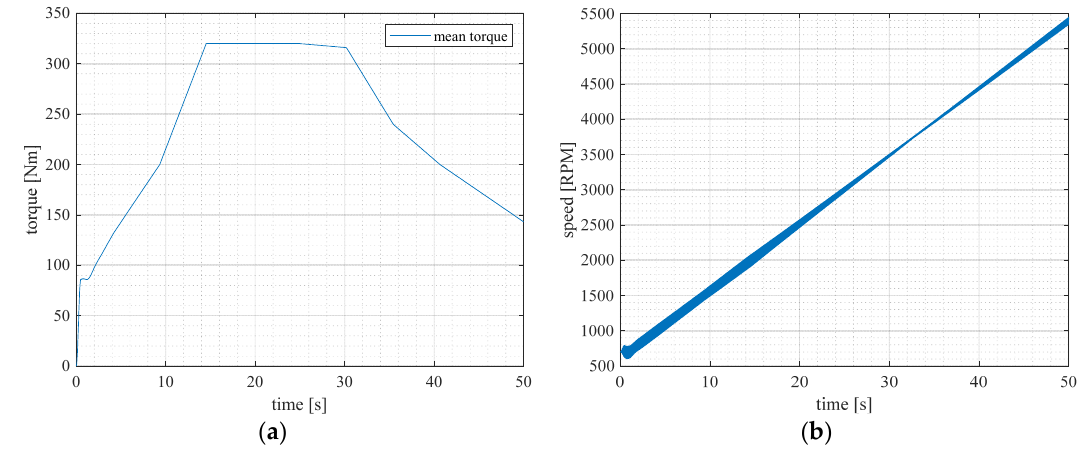
Figure 12. Mean value of the torque ( a ) and rotating speed of the ICE ( b ) during one testing cycle of the engine.